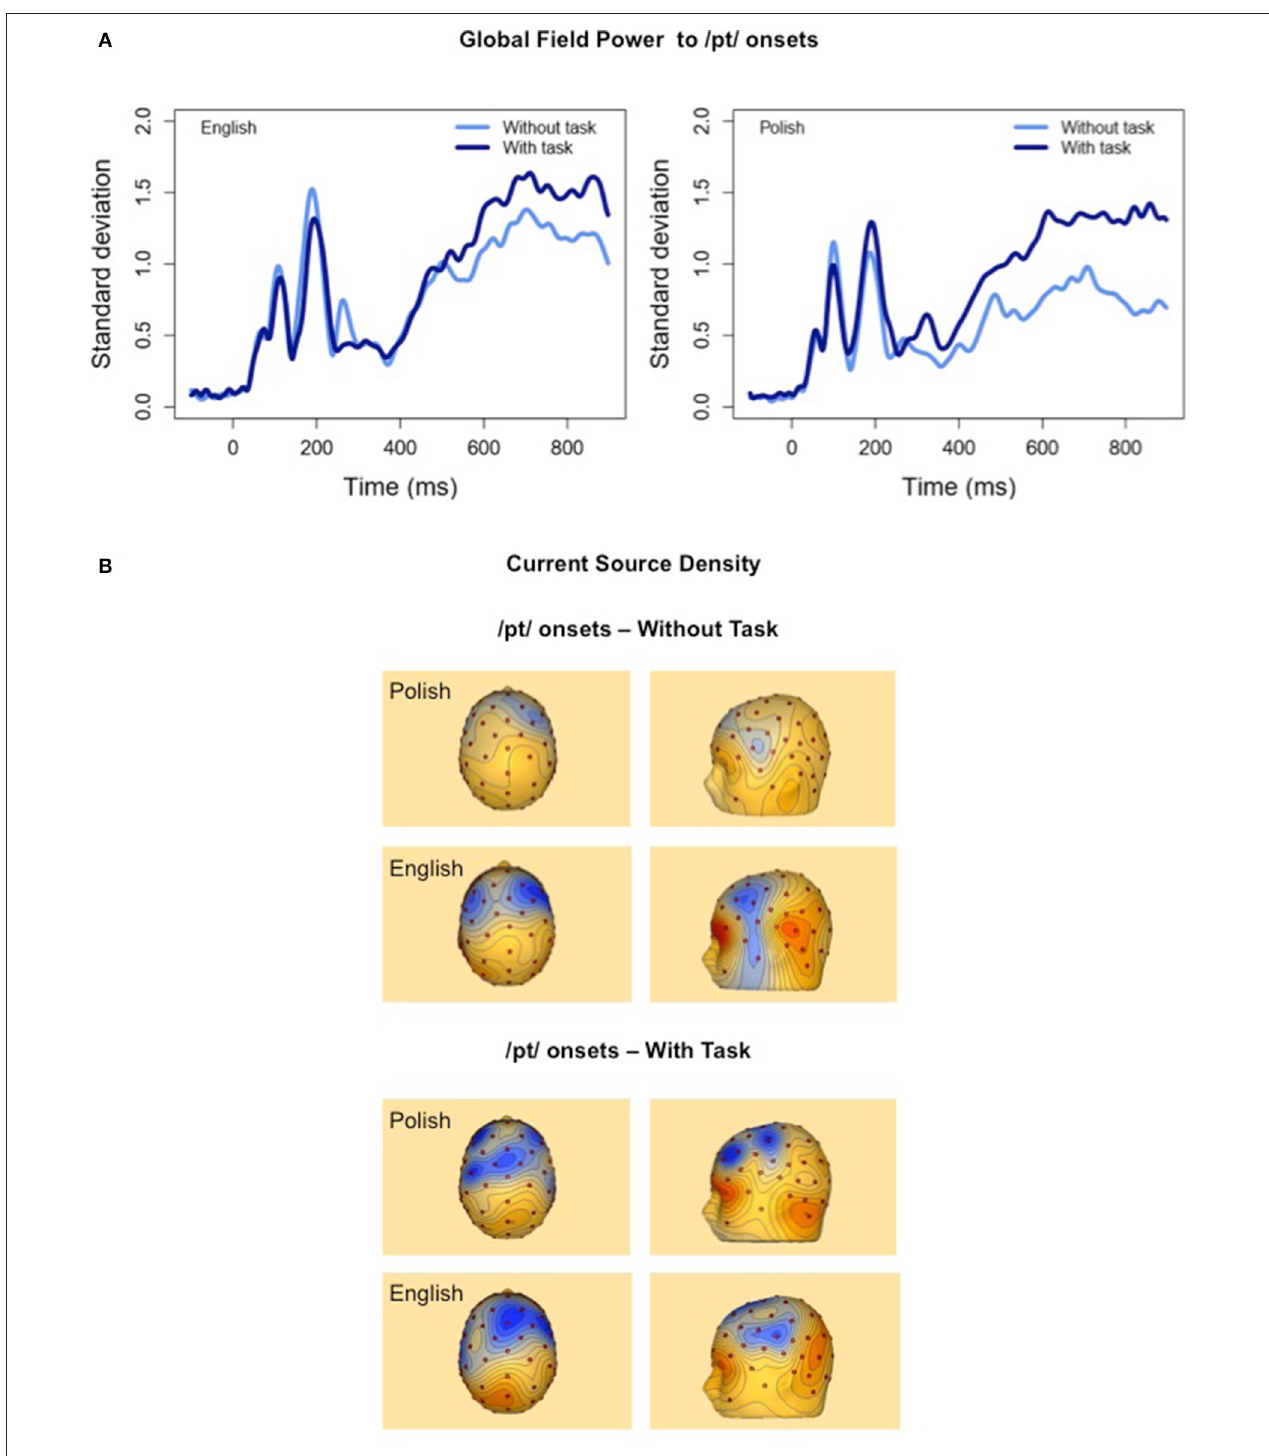
FIGURE 5 | (A) Global Field Power graphs to the /pt/ onset in English and Polish participants that support the significant interaction between attention and language experience between 400 and 900ms found for the fronto-central AEP (MEM analysis). (B) Current Source Density maps at 600ms to the /pt/ onset support the significant attention effect found for the “with task” condition (bottom) relative to the “without task” condition (top) for the Polish participants, but not the English participants (Tukey HSD). Notice that processing patterns differ for the language groups for the “without task” condition to the /pt/ onsets. English and Polish participants in the Attend 2 sequence of presentation are